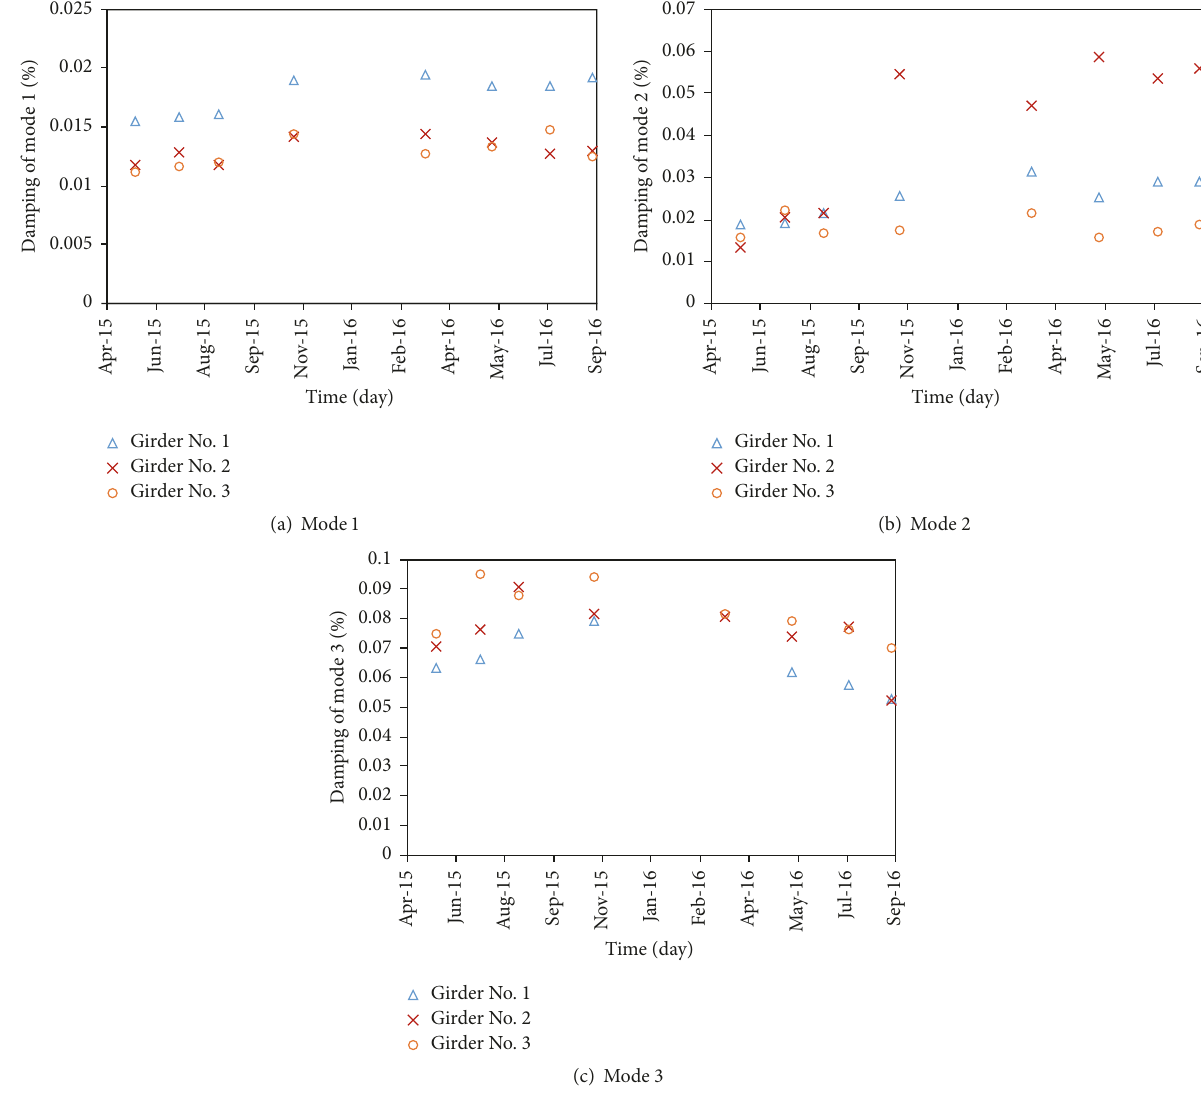
Figure 17: ((a)–(c)) Difference in damping ratios of three girders.